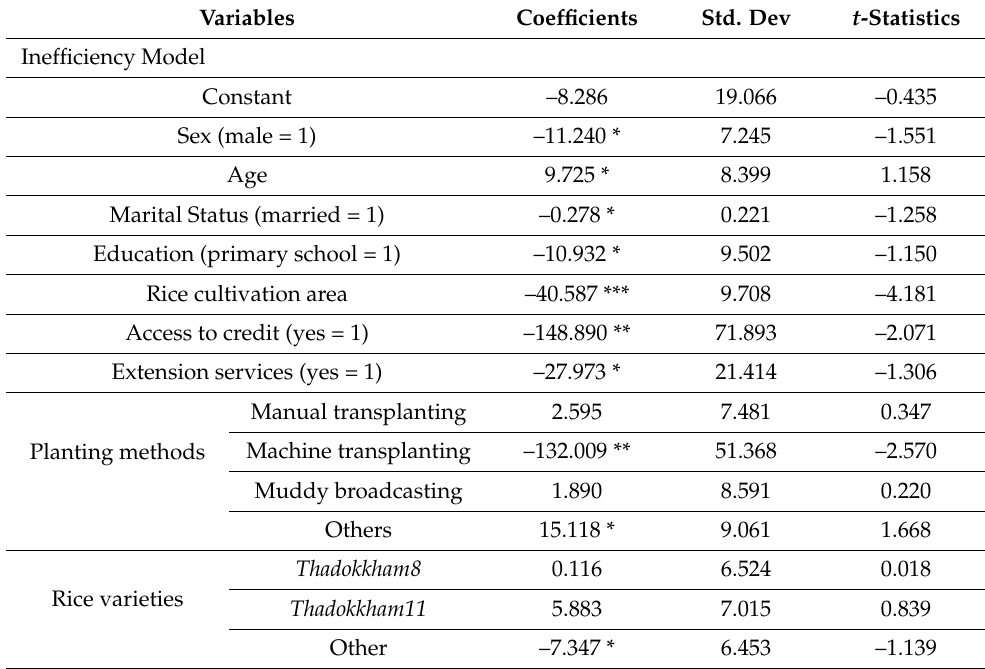
Table 3. Inefficiency Model of Wet-Season Lowland